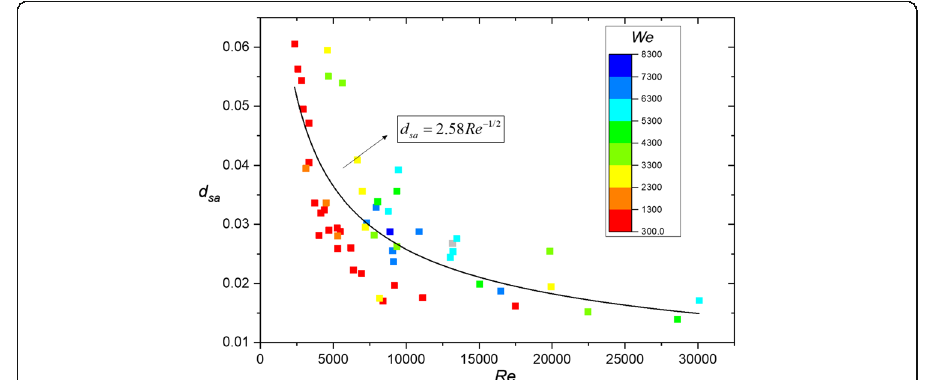
Fig. 5 Relation between the dimensionless average diameter d sa = D sa / D 0 of secondary droplets and Reynolds number Re . The symbol color represents the range of Weber number We